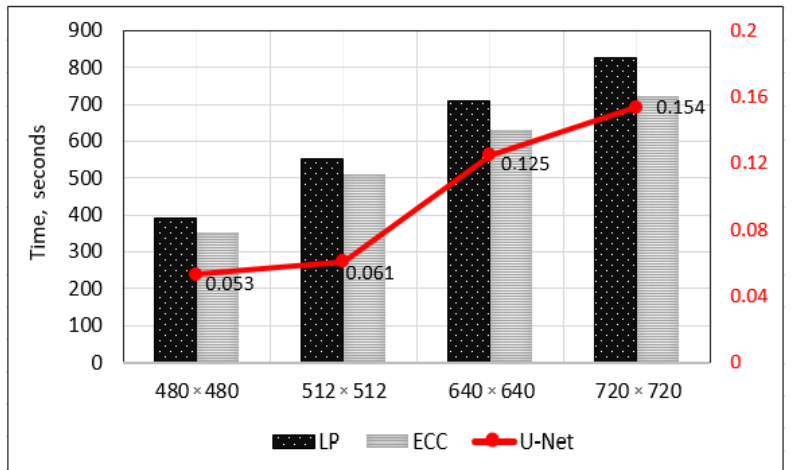
Figure 10. Comparison of fusion times using the proposed multi-focus image fusion approach using U-Net architecture, and its two alternatives such as Laplacian pyramid transform and ECC method for different resolution images.